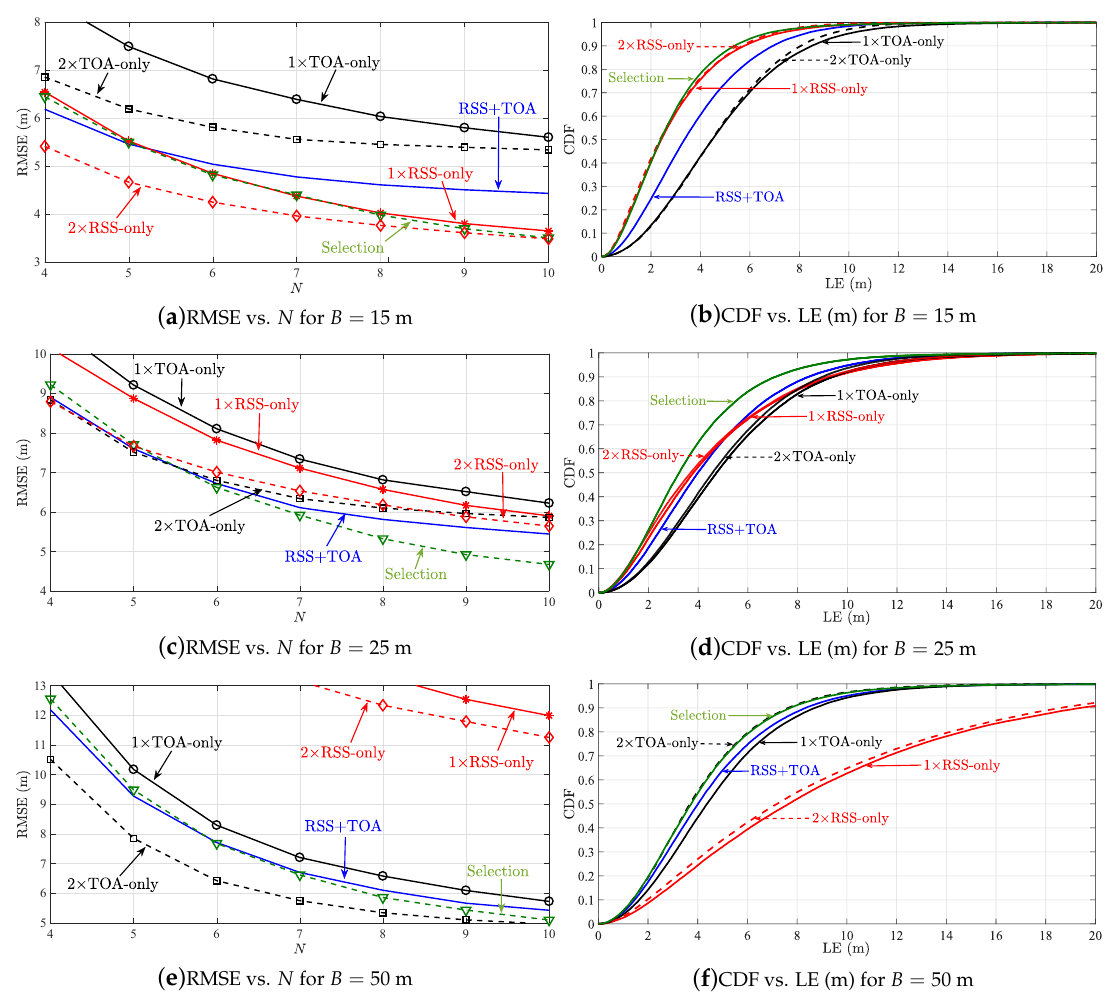
Figure 6. Simulation results for SR-WLS, when bias max = 6 (dB, m), bias i ∼ U [ 0,bias max ] (dB, m).